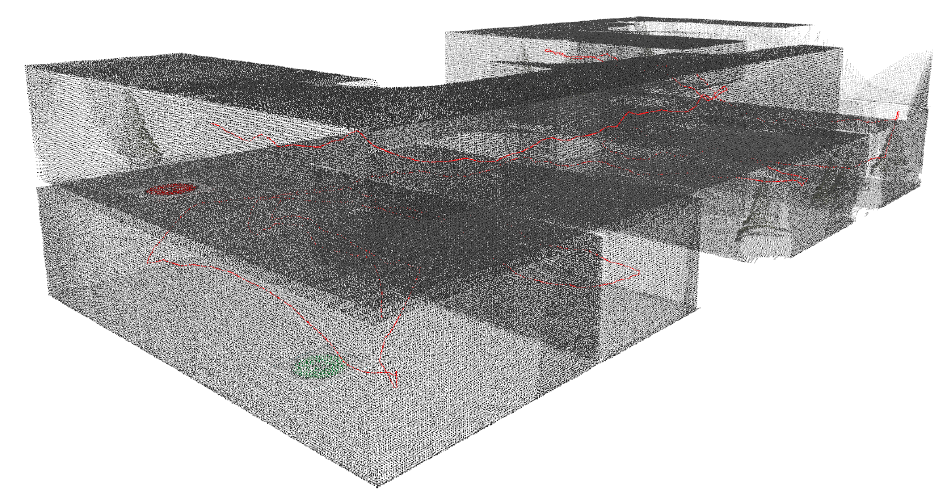
Figure 29. This figure illustrates the trajectory of the UAV from the starting location to the target location in the unknown environment from the starting location side (3D view).